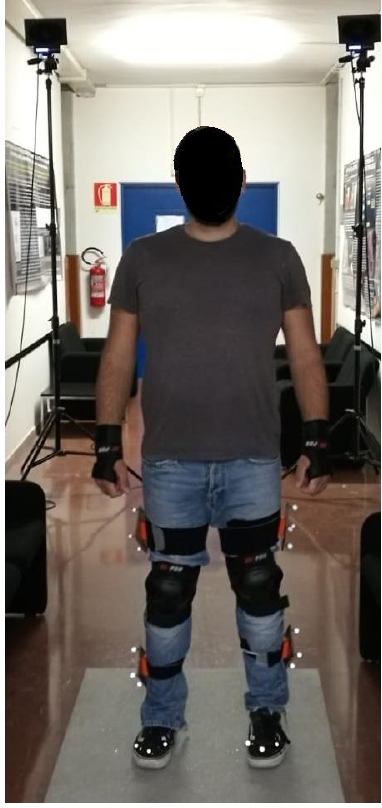
Figure 3. Subject equipped with protections and reflective markers for motion capture.